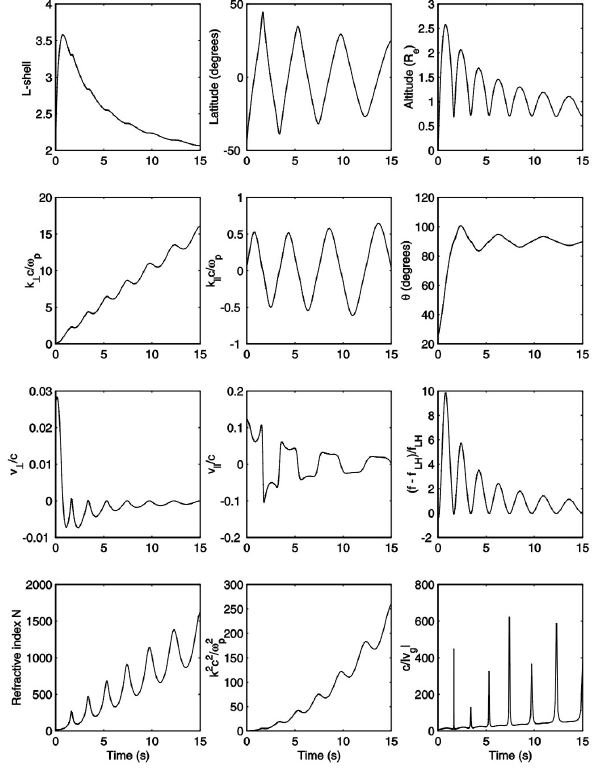
Fig. 9. Essential parameters characterizing the wave propagation shown in Fig.